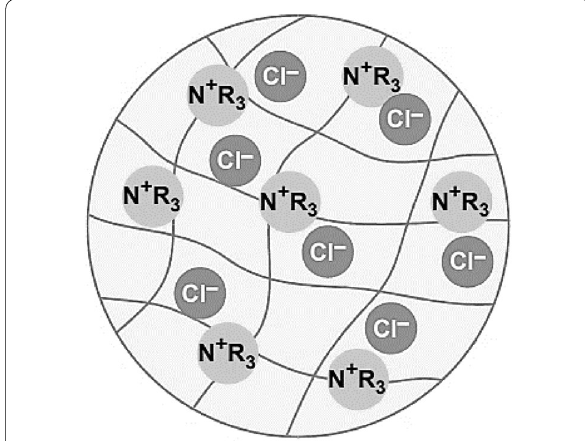
Fig. 3 Schematic anion-exchange resin beads. By permission from Rohm and Haas, Inc., Pennsylvania, United States (Rohm and Haas